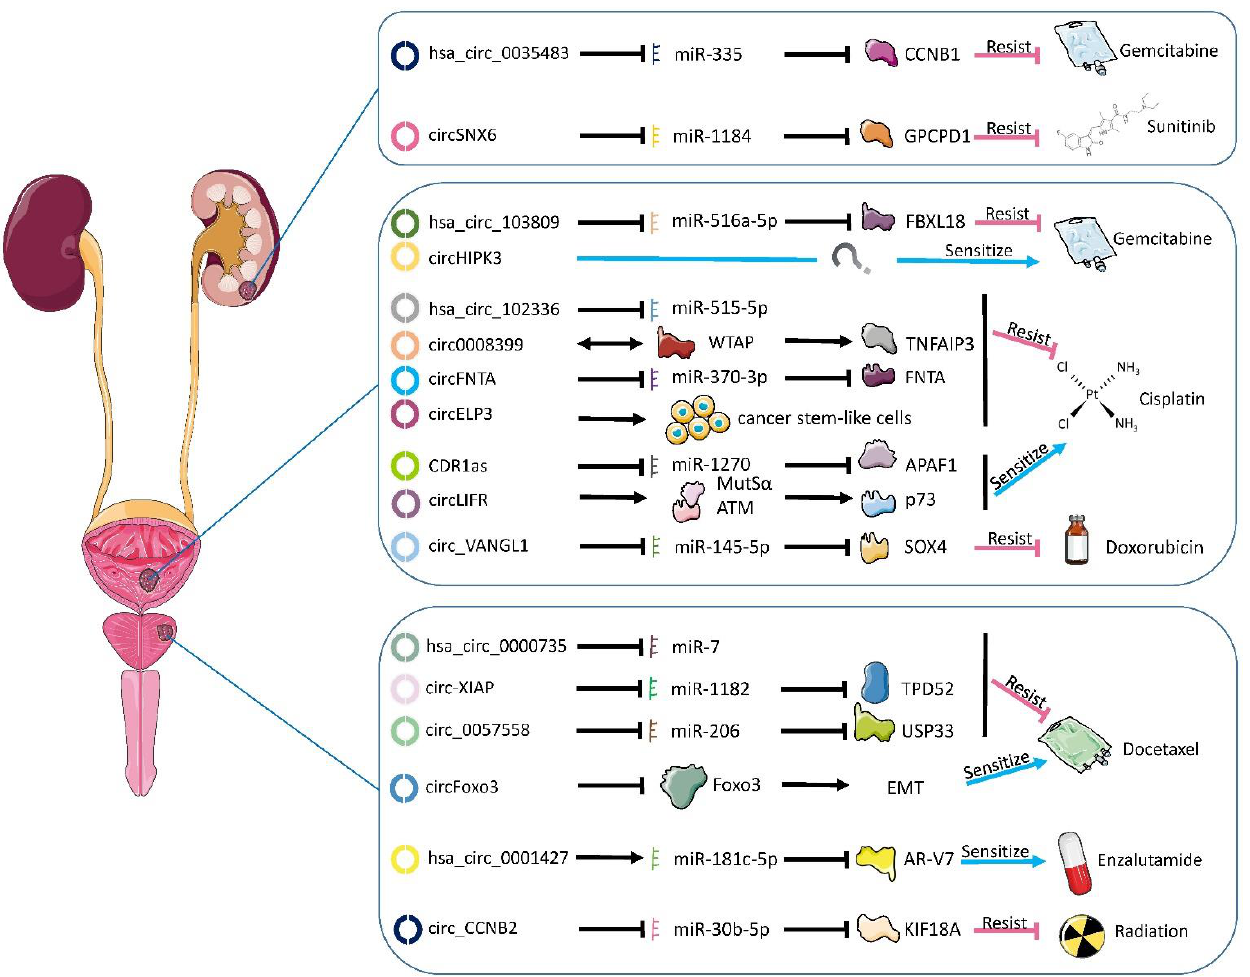
Figure 2. Functional circRNAs and their mechanisms in the development of chemotherapy and radiotherapy resistance in genitourinary. Mostly, circRNAs bind the miRNAs, thus preventing the latter from regulating their mRNA targets. Rarely, circRNAs directly interact with proteins to perform their functions. The blue/red arrow presents the effect on drug sensitivity if the circRNAs are overexpressed. Circ_CCNB2 and hsa_circ_0035483 are identical and share the same color. EMT: epithelial–mesenchymal